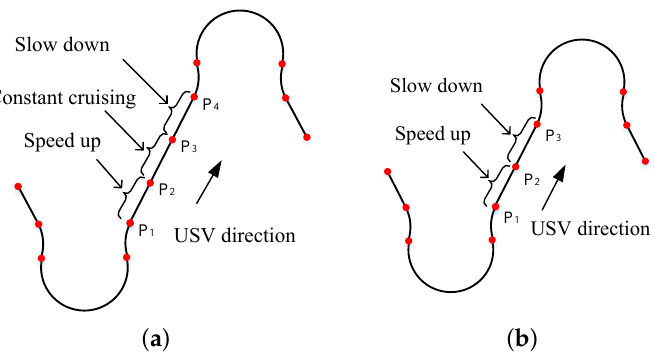
Figure 7. Speed design diagram: ( a ) The straight-line segment is sufficiently long. ( b ) The straight-line segment is not sufficiently long.